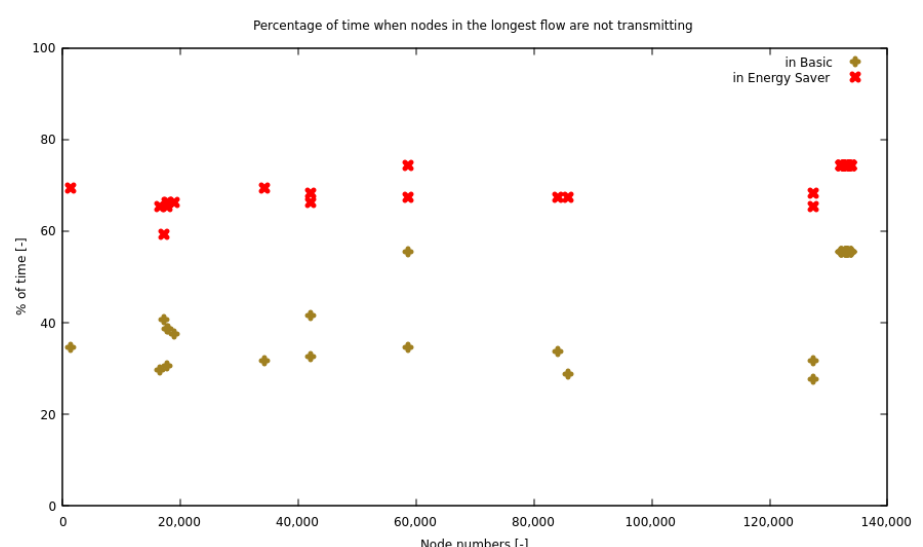
Figure 4. Comparison of the idle times in the longest flow, basic and energy-aware models. The horizontal axis displays the unique numbers of network nodes that form the path of the